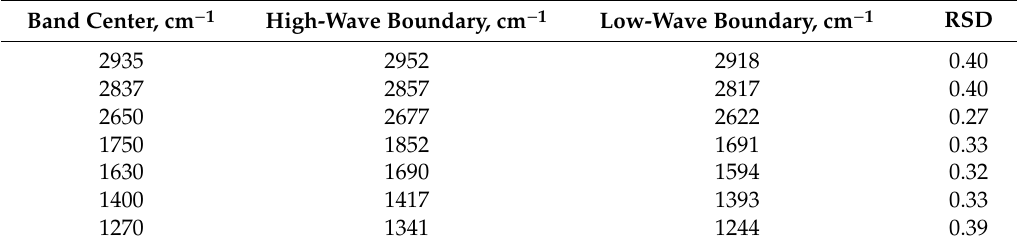
Relative standard deviation of band integral intensities in the wavenumber range 3000–2000 cm − 1 by FTIR–PAS (RDDM ND brand).